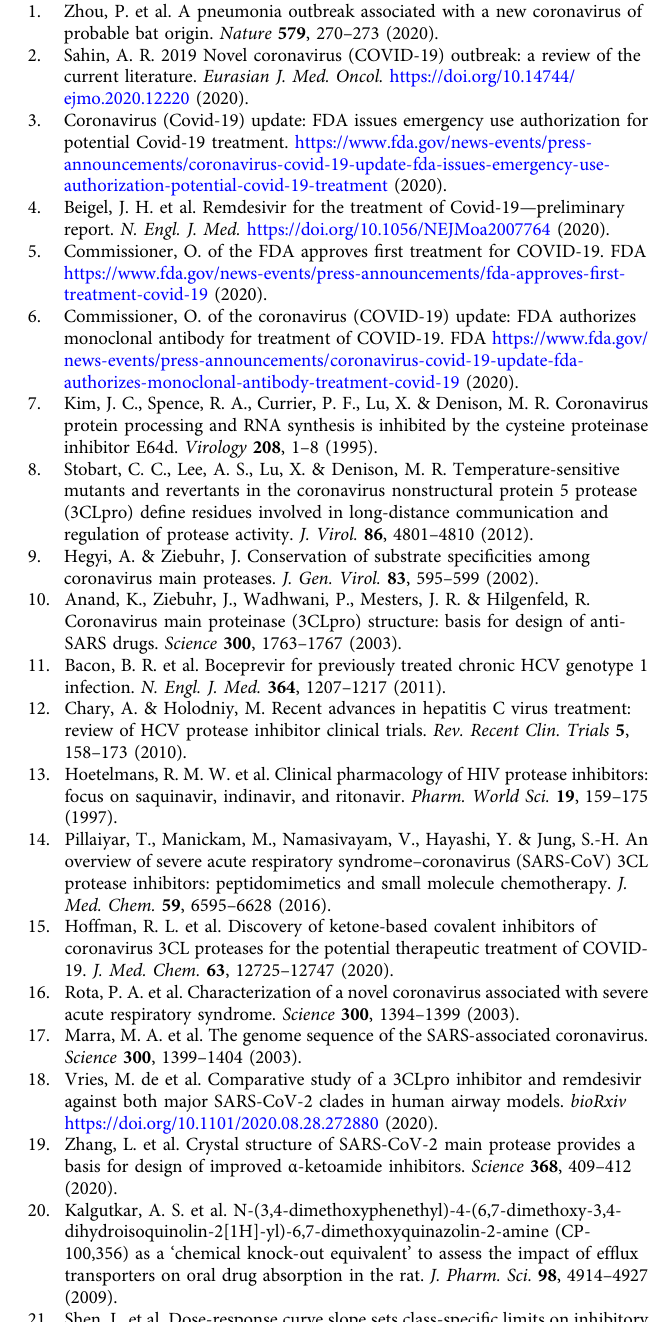
Figure 3 Sera_1. https://doi.org/10.6084/m9. fi gshare.15175854.v1 Figure 3 Sera_2. https://doi.org/10.6084/m9. fi gshare.15175857.v1 Figure 4B. https://doi.org/10.6084/m9. fi gshare.16527984.v1 Figure 4C. https://doi.org/10.6084/m9. fi gshare.16527990.v1 Figure 4E. https://doi.org/10.6084/m9. fi gshare.16527996.v1 Figure 4F. https://doi.org/10.6084/m9. fi gshare.16528005.v1 Figure 6A. https://doi.org/10.6084/m9. fi gshare.15162546.v1 Figure 6B. https://doi.org/10.6084/m9. fi gshare.15162549.v1 Supplement Figure S2A. https://doi.org/10.6084/m9. fi gshare.15162780.v1 Table S4. https://doi.org/10.6084/m9. fi gshare.15162771.v1